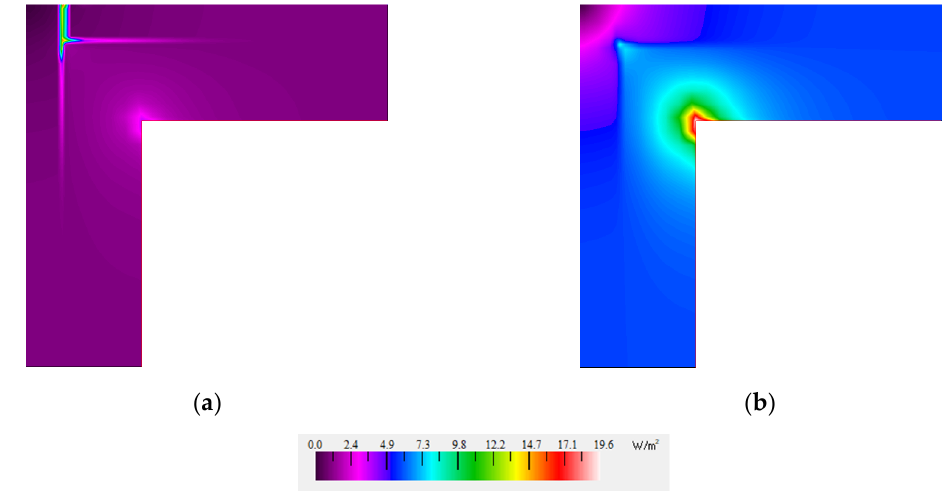
Figure 7. The heat flow rate through the wall corner insulated with: ( a ) aluminum foil-faced PIR, without PU glue in the joint; ( b ) PIR without facing and without PU glue in the joint.